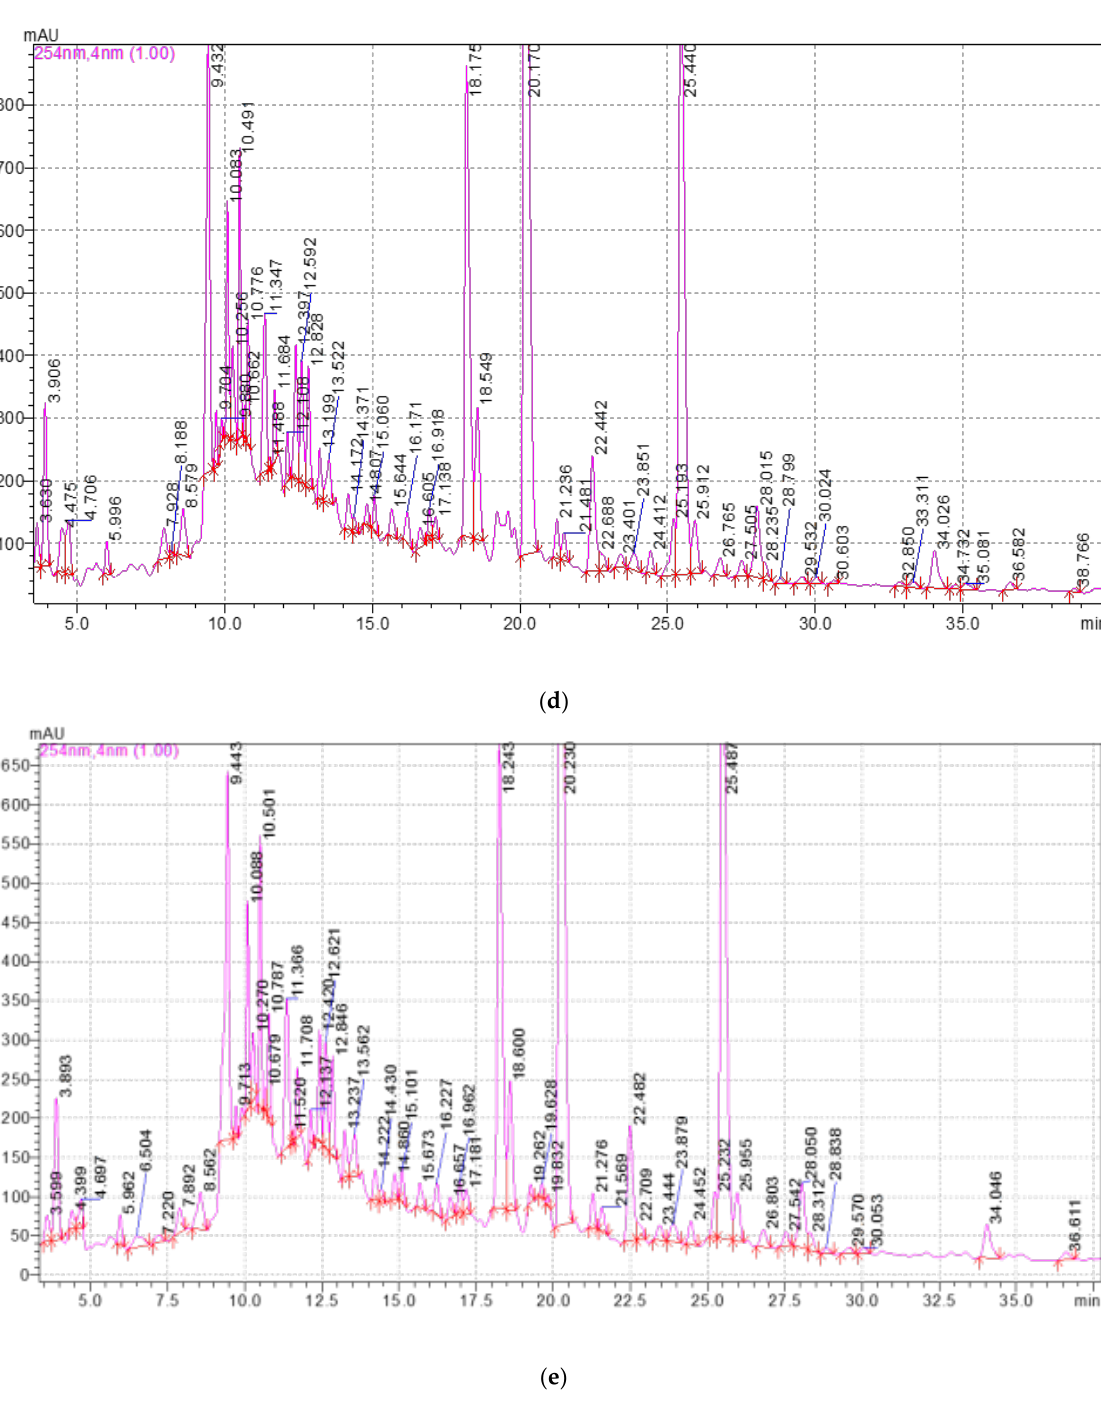
Figure 6. Chromatograms of extracts of different extraction times without ultrasonic treatment: ( a ) 10 min; ( b ) 15 min; ( c ) 20 min; ( d ) 25 min; ( e ) 30 min. The quantitative content of BASs found in extracts obtained with and without US treatment are presented in Tables 2 and 3.